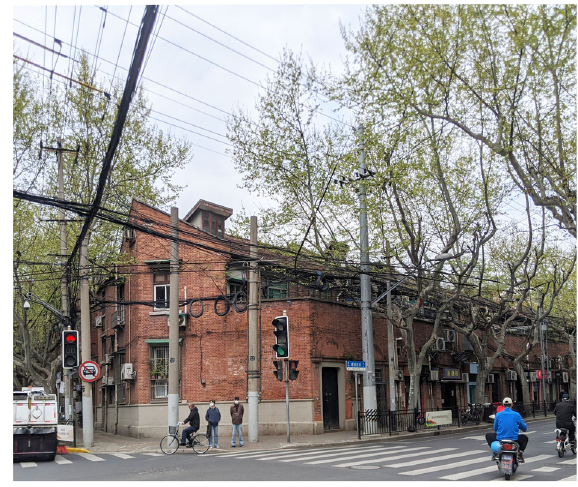
Fig. 2 The view of Bugaoli Neigbourhood from the intersection of the South Shaanxi Road ( Avenue du Roi Albert ) and the West Jianguo Road ( Route J. Frelupt ) (Source: Kaiyi Zhu,